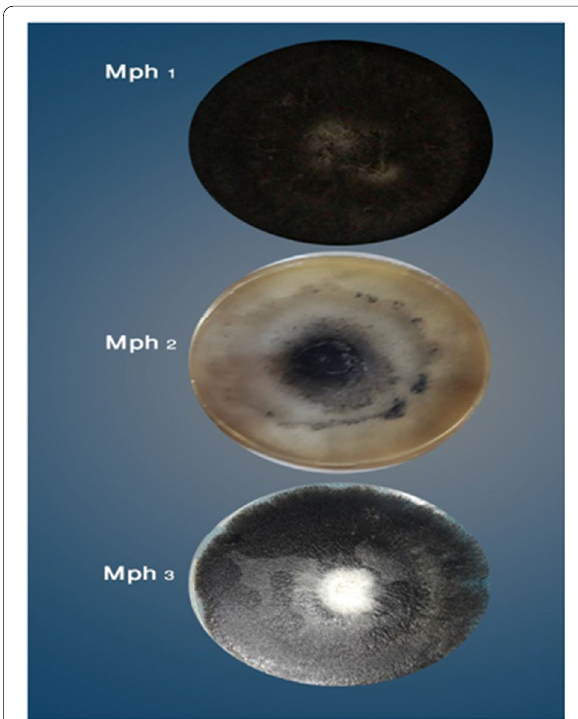
Fig. 8 Different culture of M. phaseolina isolated from infected soil and wheat root samples